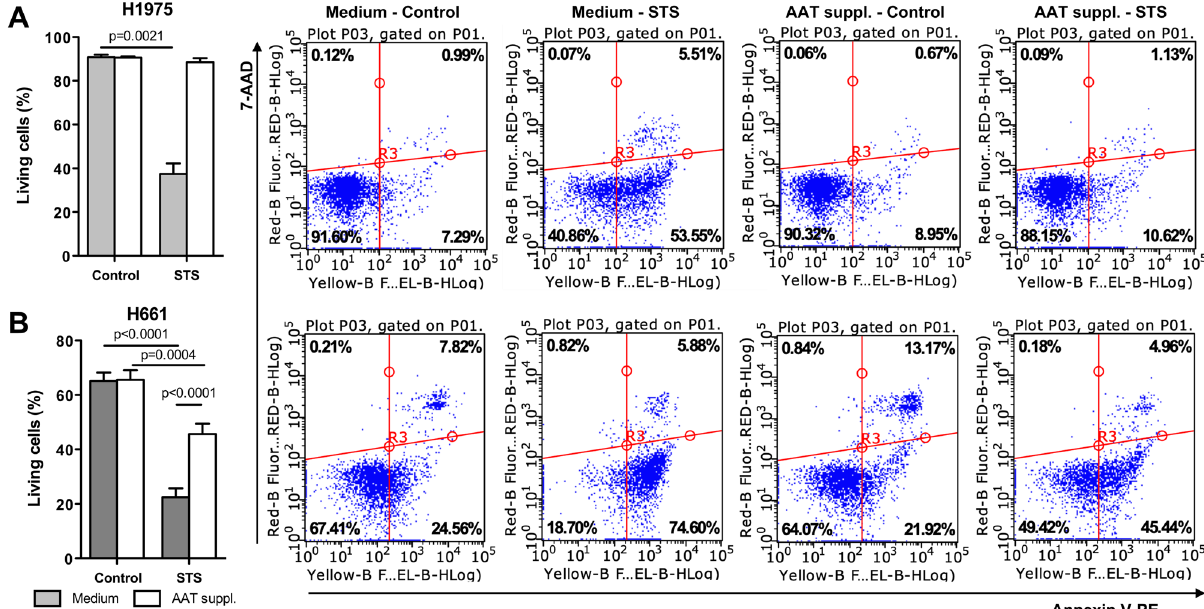
Figure 3. H1975 and H661 cells cultured in medium supplemented with 2 mg/ml AAT for 3 weeks show increased resistance to staurosporine (STS)-induced apoptosis. All experimental data were generated from two independent cell cultures of H1975 and H661 cells cultured twice in complete medium without or with supplementation with AAT for 3 weeks. ( A ) (H1975) and ( B ) (H661) cell supernatants were removed and 50 nM STS was added in serum free RPMI for 18 h. Apoptosis was measured by flow cytometry using PE Annexin V Apoptosis assay. In the bottom left quadrant shown cells classified as “living”. Cells cultured in regular medium ( grey bars) and in medium supplemented with AAT ( clear bars). Each bar represents mean (SD) of three repeats from independent experiments. p < 0.05 was considered as